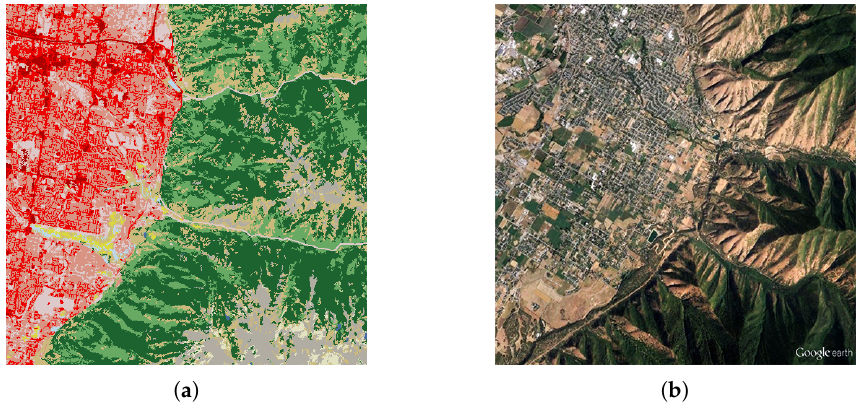
Figure 16. Reference scene III located in Mapleton, Utah, USA. ( a ) The scene in NLCD 2006; ( b ) The remotely sensed image taken from Google Earth on the same region of the reference scene shown in (a) (for visualization, the histogram of the image has been stretched).